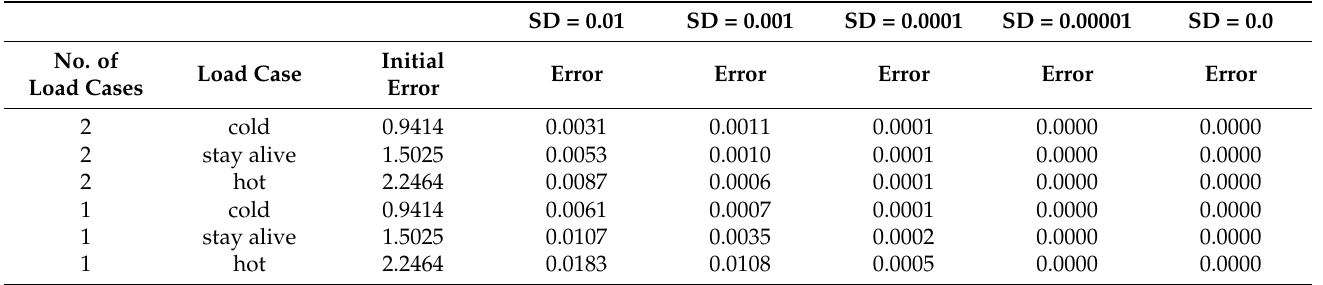
Table 4. Errors obtained for predicted temperatures for transient 4 nodes